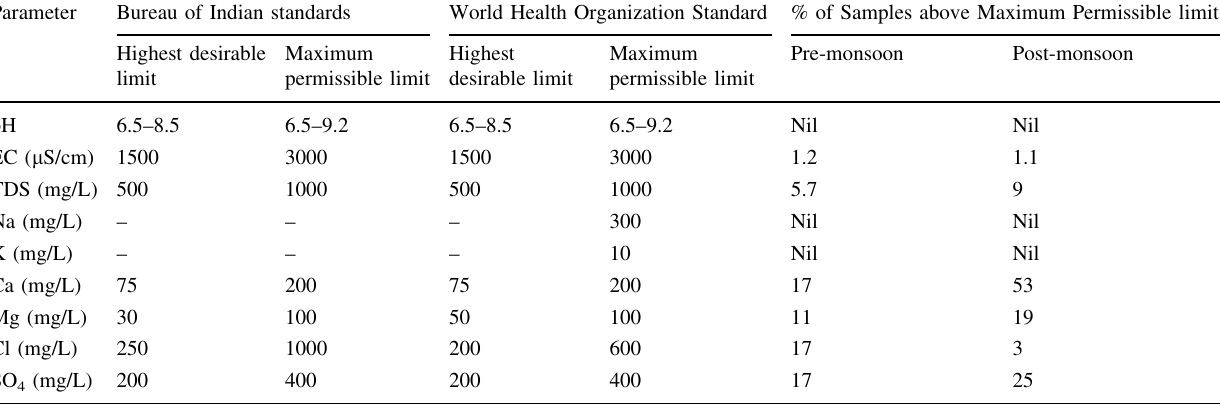
Table 2 Comparison of groundwater samples with BIS and WHO standards Parameter Bureau of Indian